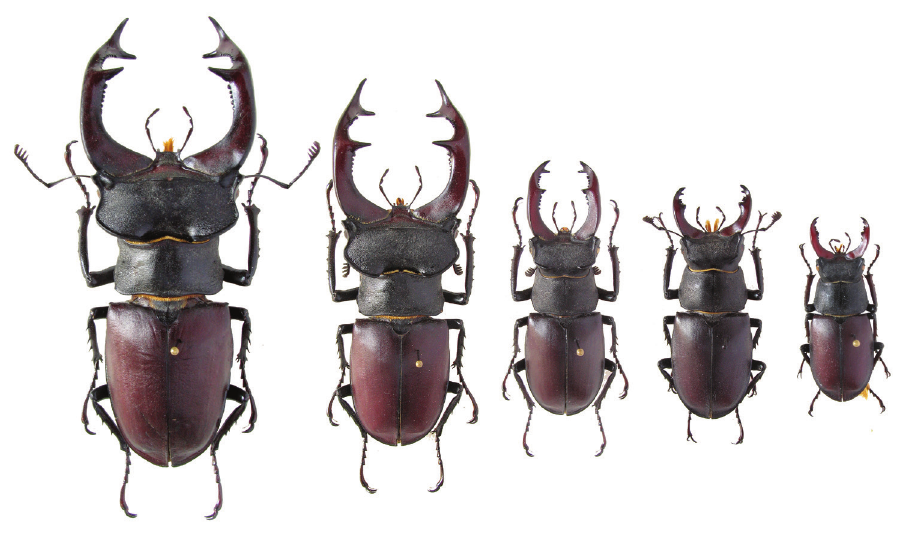
Figure 5. Polymorphism in Lucanus cervus males (all specimens from northern Italy; photo by M.